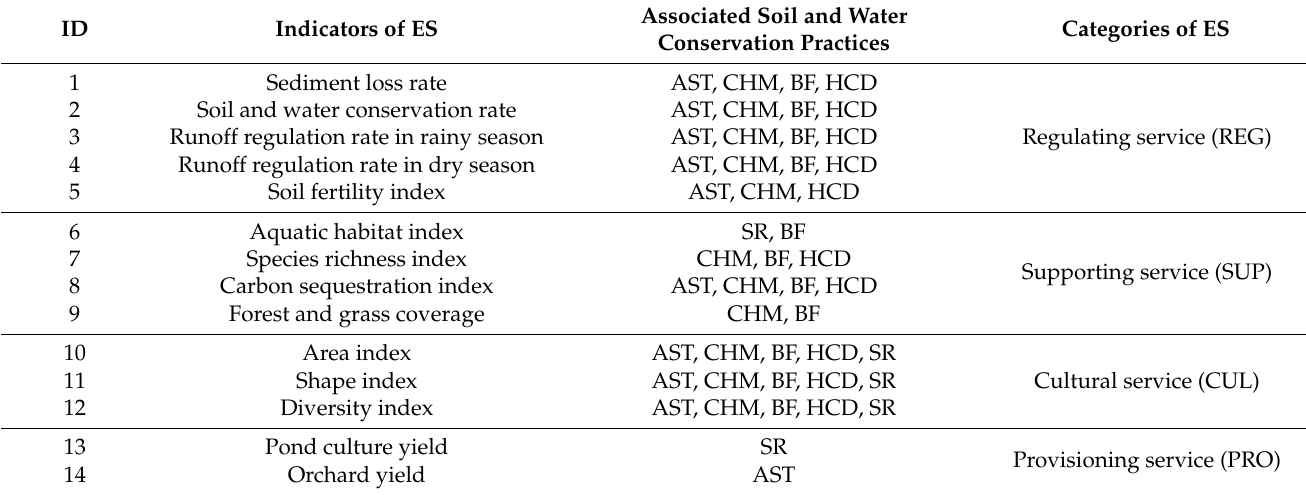
Table 3. The indicators of ES and associated soil and water conservation